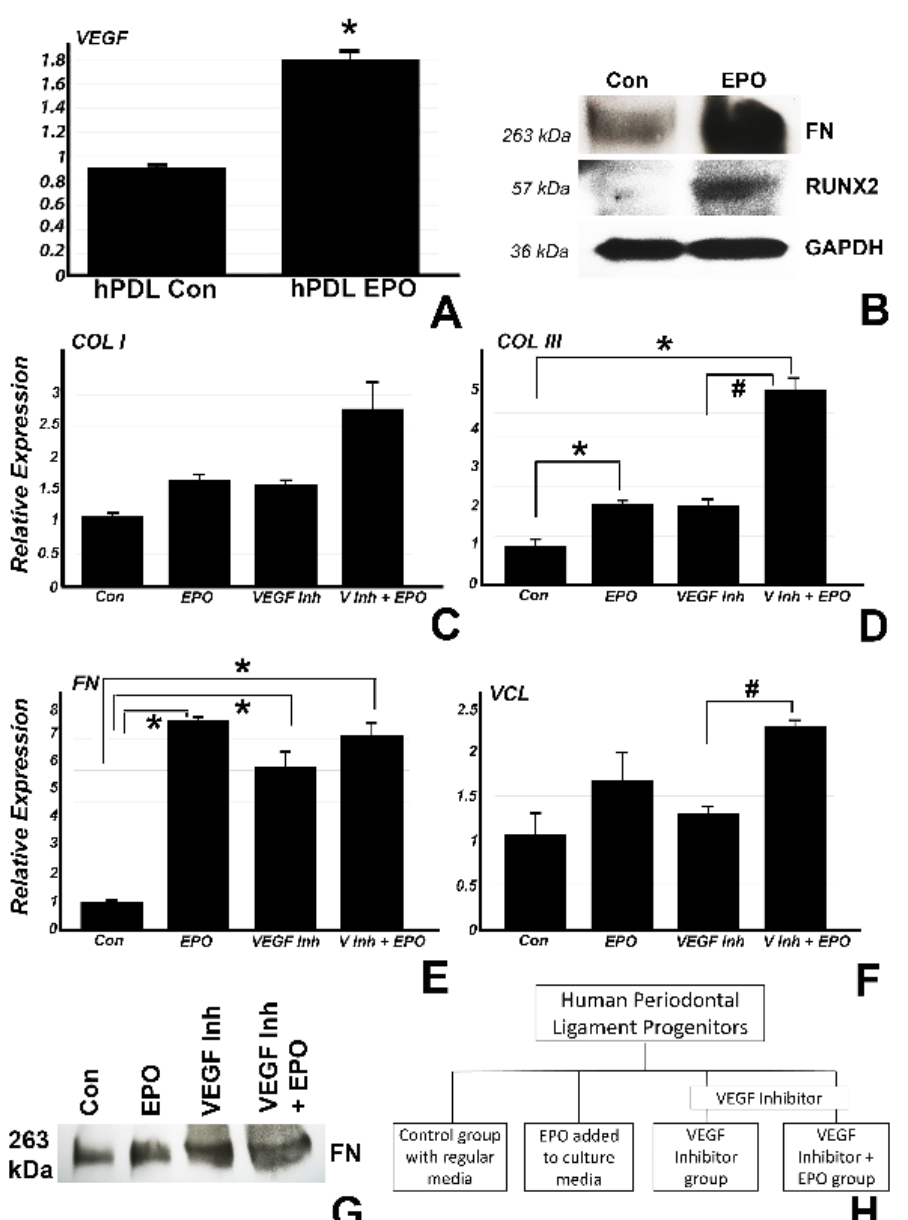
Figure 4. Relative Vegf gene expression in cultured hPDL cells was significantly upregulated fol- lowing treatment with 0.5 µ g/mL EPO for 1 week compared to the control group ( A ). Western blot analysis confirmed an increase in Fibronectin (FN) matrix protein and Runx2 osteoblast differentia- tion factor expression in the EPO group compared to the control ( B ). For pathway analysis studies, cultured hPDL cells were treated with control media, 0.5 µ g/mL EPO, 10 µ m VEGF inhibitor and VEGF inhibitor with EPO addition for 24 h ( C – H ) and the effect of treatment conditions on collagen I, III, fibronectin, and vinculin was assessed. In these studies, EPO treatment resulted in a significant upregulation of Collagen III ( D ) and FN ( E ) compared to the control confirming the capability of EPO to promote new mineralization and matrix formation. Inhibiting VEGF while adding EPO further upregulated the expression levels of collagen III ( D ), fibronectin ( E ) and for vinculin ( F ) in a significant fashion. The effect of EPO, VEGF inhibitor treatment, and EPO rescue on fibronectin protein expression was confirmed by Western blot ( G ). The statistically significant difference of p < 0.05 between an experimental group versus the control is indicated by an * and a statistically significant difference of p < 0.05 between two experimental groups is indicated by a